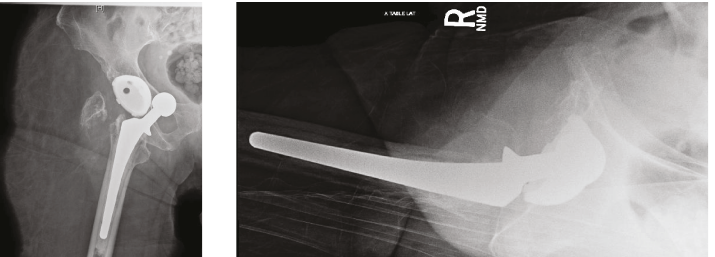
Figure 2: Anteroposterior (AP) and lateral right hip radiographs, status post attempted closed reduction revealing right iatrogenic obturator hip dislocation with femoral component intrapelvic migration.